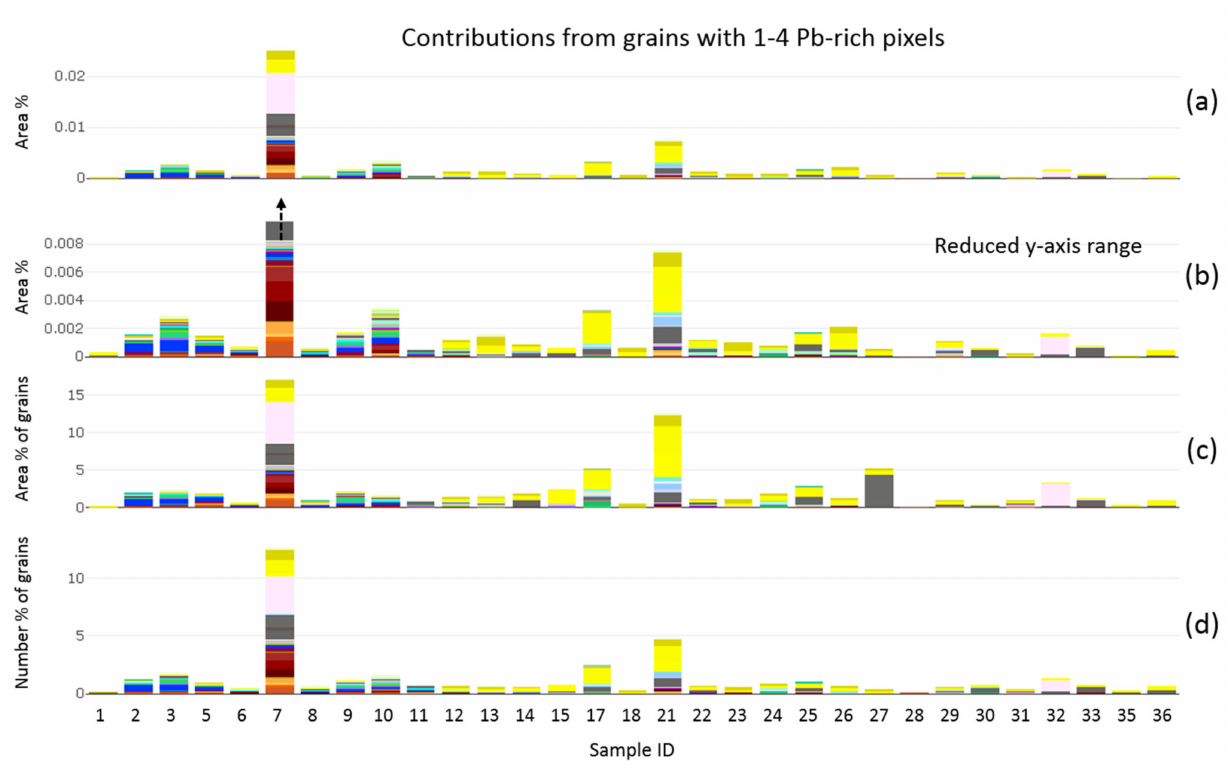
Figure 16. As Figure 14 after filtering data by excluding those grains with ≥ 5 Pb-rich pixels. ( a ) contributions of Pb-rich pixels from grain populations (as area % with respect to sample); ( b ) as ( a ) but with reduced y-axis range; ( c ) host grains as percentage of total grains in sample, by grain area; ( d ) as ( c ) but by number of grains. Colour scheme for grain populations as Figure